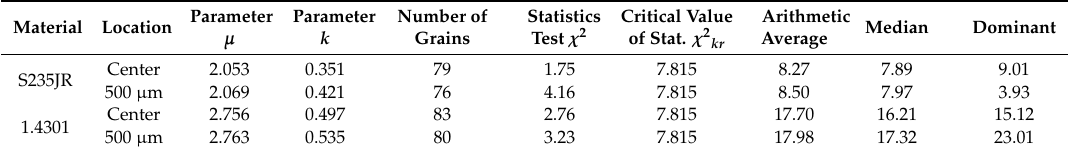
Table 4. Values of logarithmic normal distribution parameters for the grain size d .